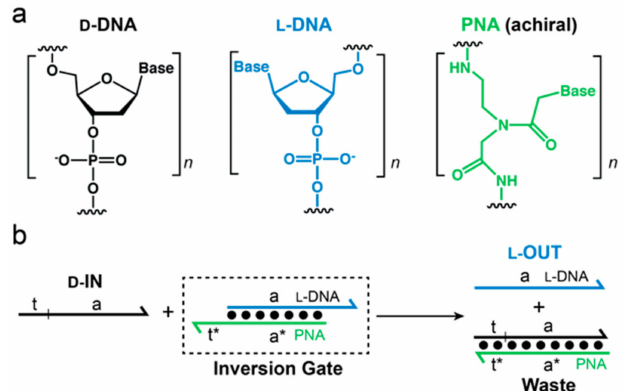
Figure 1. ( a ) Three types of nucleic acids used in this work. d -DNA (black), l -DNA (blue), and peptide